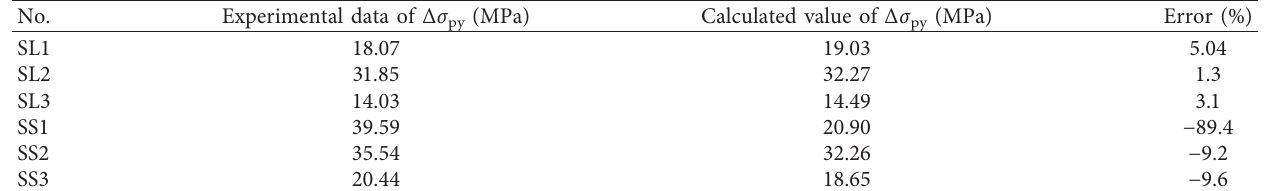
py β s and β 0 py .